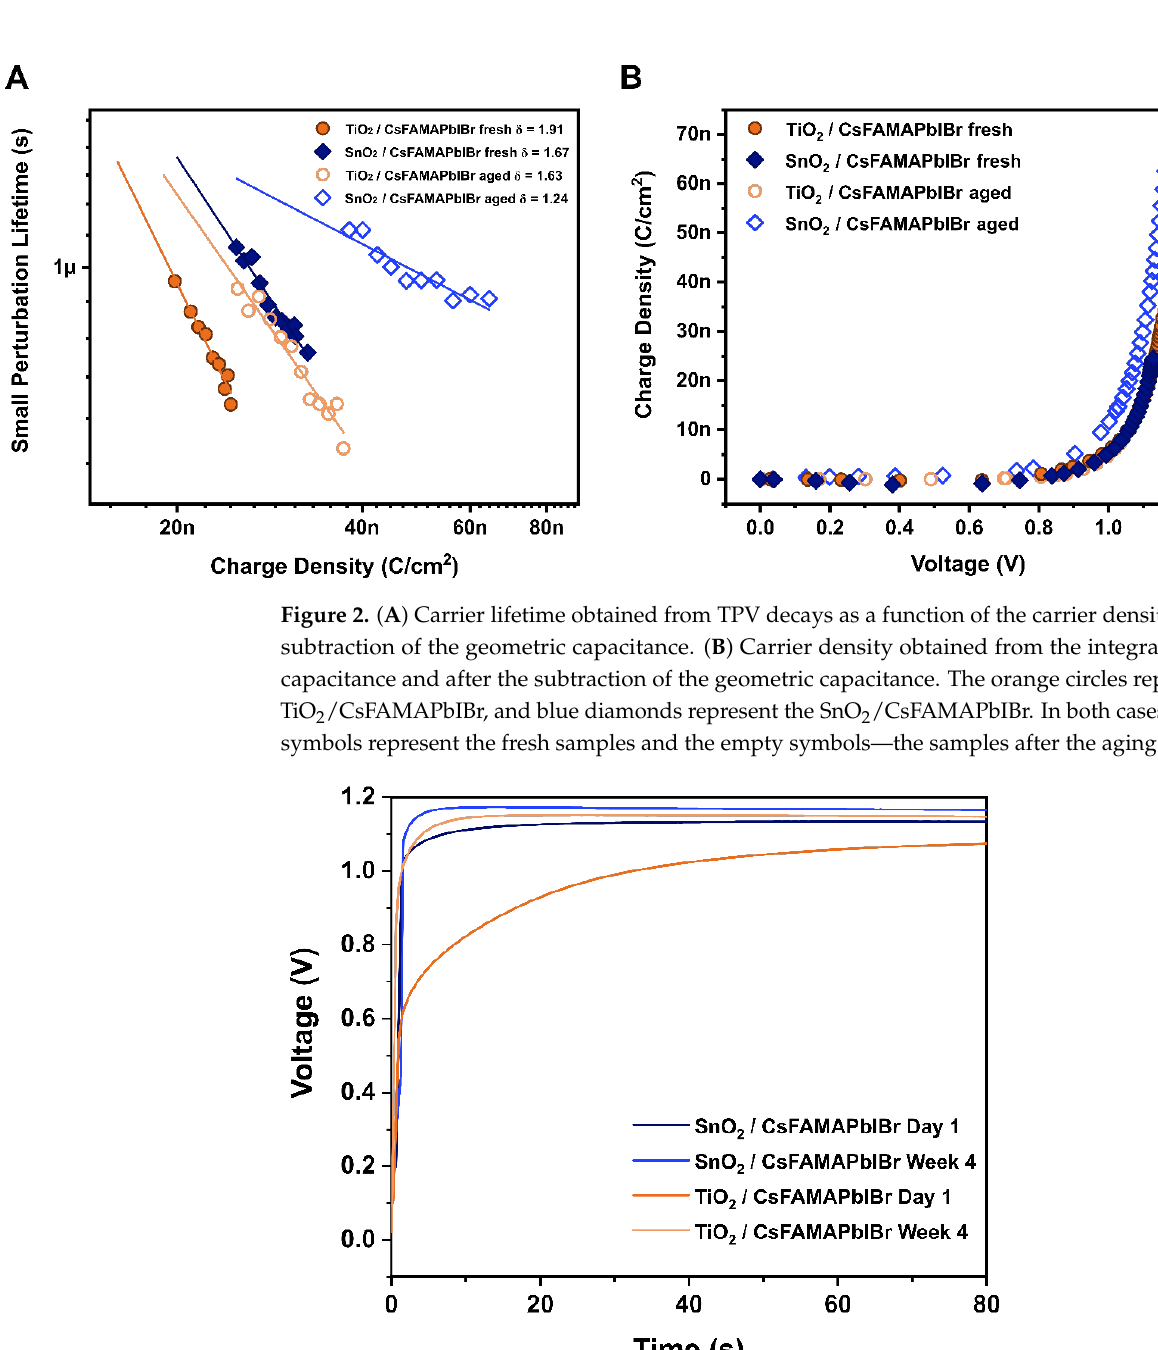
Figure 3. V OC stability over time for CsFAMAPbIBr on TiO 2 and SnO 2 for fresh and aged devices. This slow V OC stabilization is associated with the ionic redistribution in the perovskite layer, a slow process that affects carrier recombination, inducing slower V OC values until ions redistribute in the bulk of the perovskite [13,16]. During this time, when TPV transient pulses are registered—at 3, 5, 10 and 30 s—a negative spike appears. This negative transient, associated with an increased recombination at the interfaces is observable in every fresh device (see Figure 4A,C). Then, after the aging treatment (see Figure 4B,D), this spike is reduced for the case of TiO 2 , or it even disappears, as with SnO 2 -based devices and, as previously observed, after aging for 45 days [17]. These results suggest that the ionic accumulation at the interfaces enhances recombination, most likely, trap-assisted carrier recombination, thus yielding lower values of V OC . After storing the devices under dry